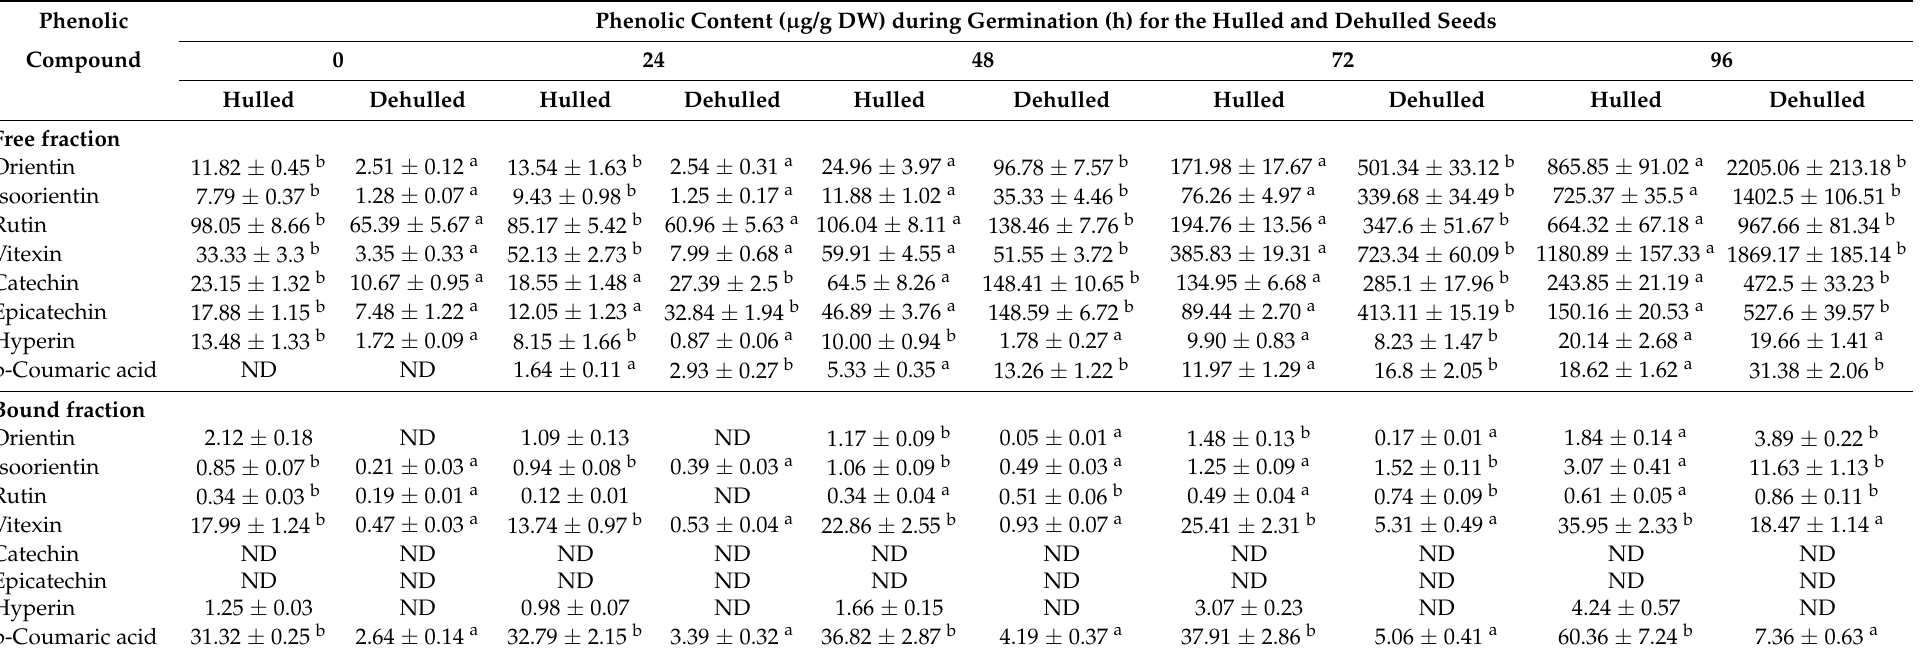
Table 2. Contents of the individual phenolic compounds ( µ g/g dry weight (DW)) in the free and bound fractions of the germinating buckwheat